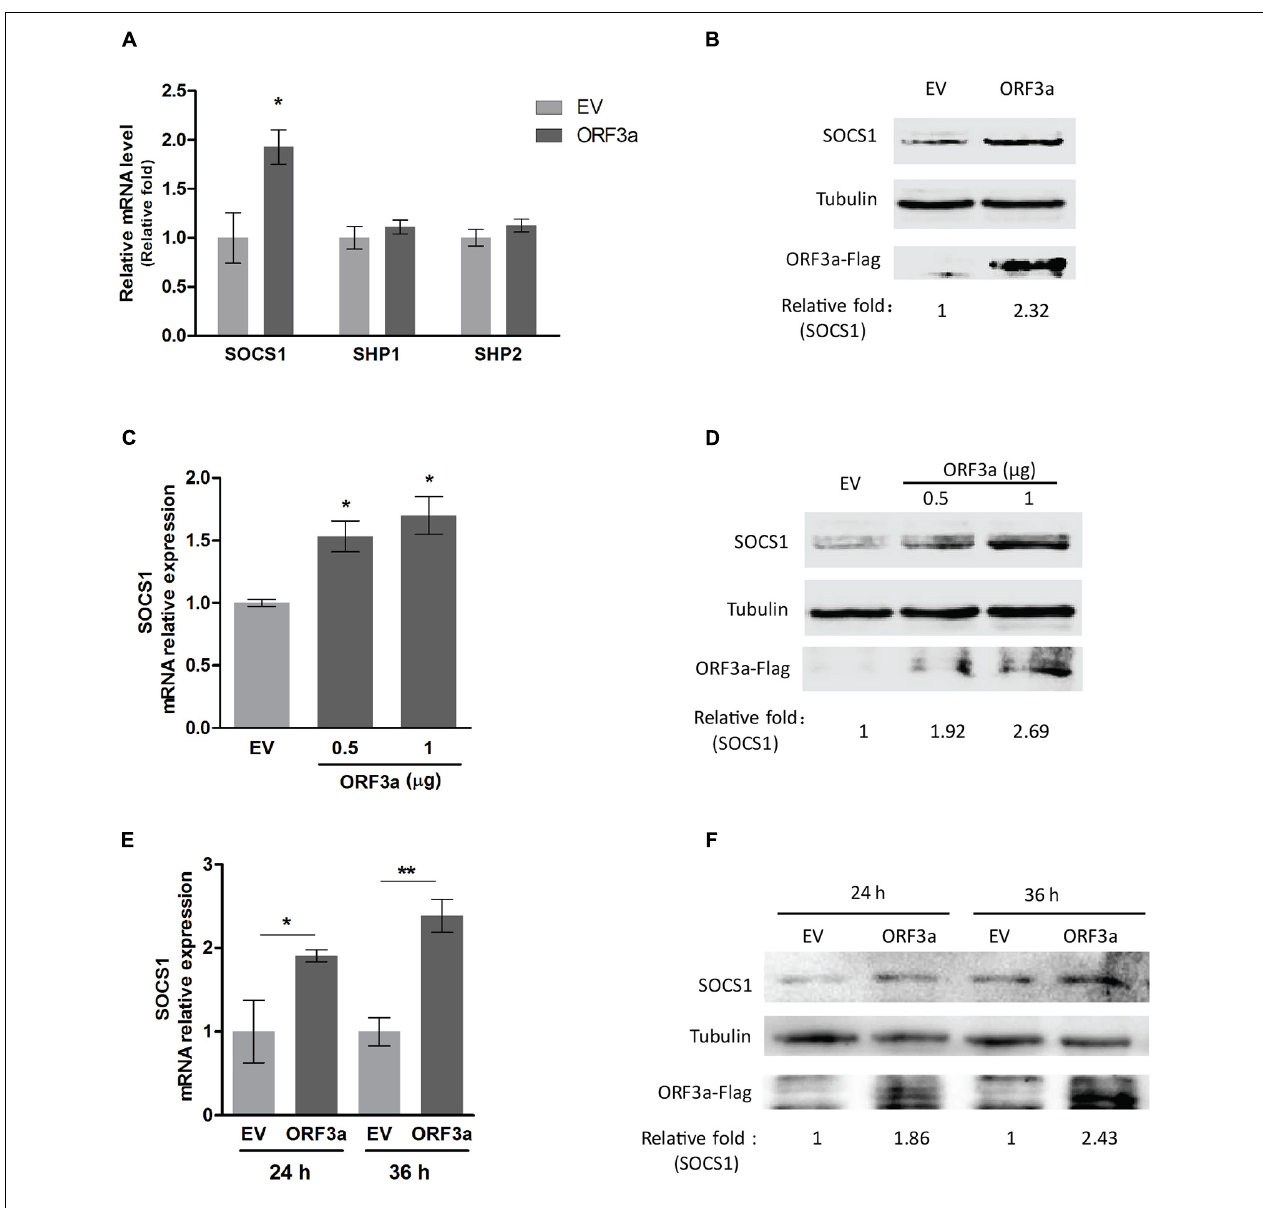
FIGURE 3 | ORF3a increases SOCS1 expression. (A) ORF3a increases the transcription level of SOCS1 instead of SHP1 and SHP2. HEK293T cells were transfected with empty vector (EV) or ORF3a plasmid. At 24 h after transfection, the cells were harvested for RT-qPCR. (B) ORF3a increases the protein level of SOCS1. Cells were treated similarly as A, then harvested at 36 h after transfection for immunoblotting. (C,D) ORF3a induces SOCS1 upregulation in a dose-dependent manner. HEK293T cells were transfected with incremental amounts of ORF3a plasmid for determining SOCS1 at mRNA (C) and protein (D) levels. (E,F) ORF3a increases SOCS1 expression along with time extension. The cells transfected with EV or ORF3a plasmid were harvested at 24 and 36 h after transfection. The transcripts (E) and proteins (F) of SOCS1 were detected. Error bars represent standard errors of the results of repeated experiments. Significant differences from the EV-transfected control cells are denoted by “*” and “**”, which indicates P < 0.05 and P < 0.01, respectively. In densitometry analysis, relative levels of SOCS1 in comparisons with EV samples are shown as folds below the images after normalization with